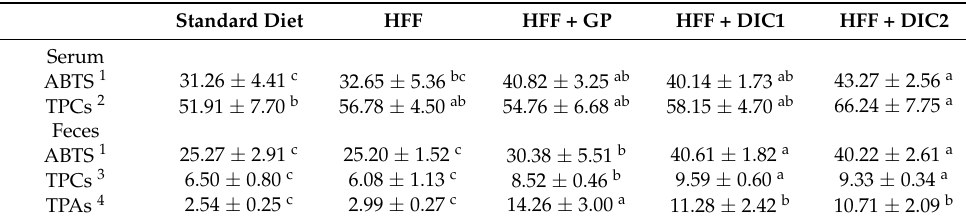
Table 2. Phenolic compounds and antioxidant capacities in feces and sera of rats fed a HFF diet supplemented or not with grape pomace subjected or not to